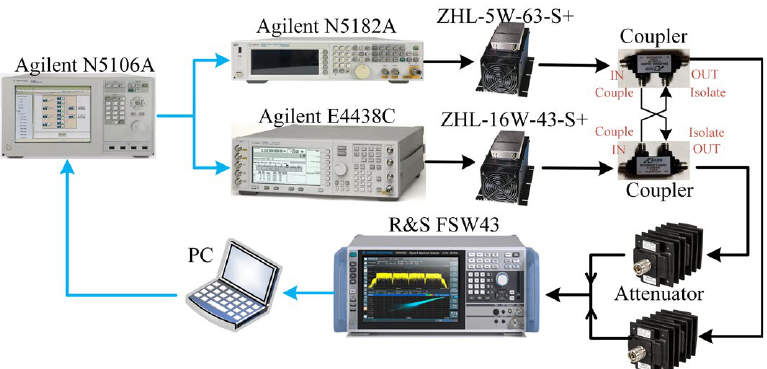
Figure 6. The block diagram of the experimental platform when linear crosstalk is introduced.